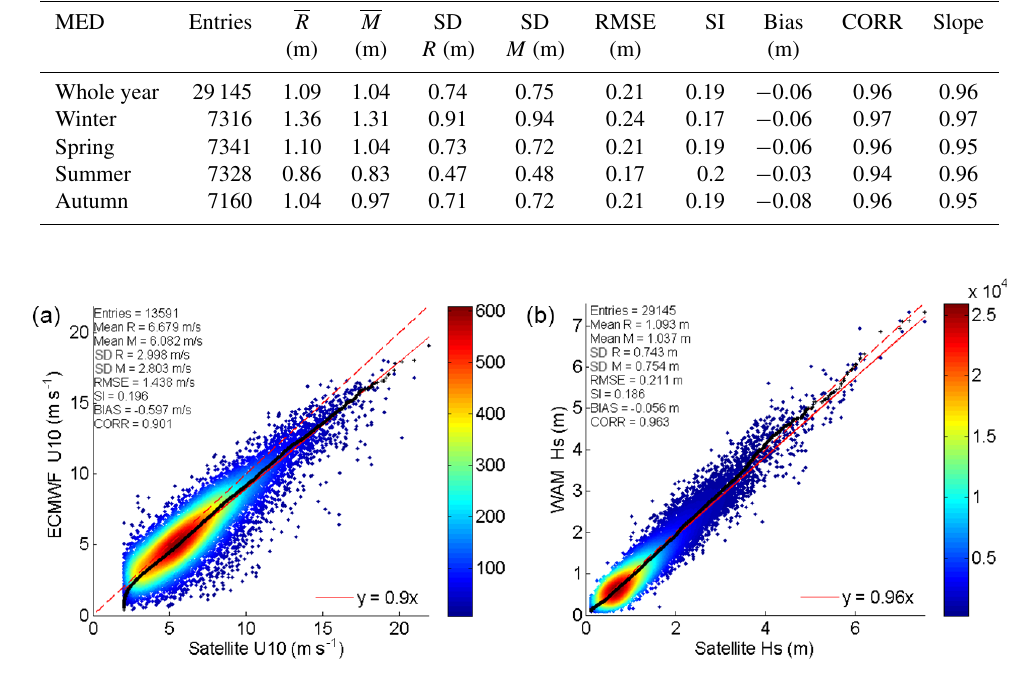
Figure 7. QQ–scatter plots of (a) ECMWF forcing wind speed U 10 versus satellite U 10 (Jason-2) and (b) Med-waves H s versus satellite H s (Jason-2 and SARAL), for the full Mediterranean Sea, for a 1-year period (2014).